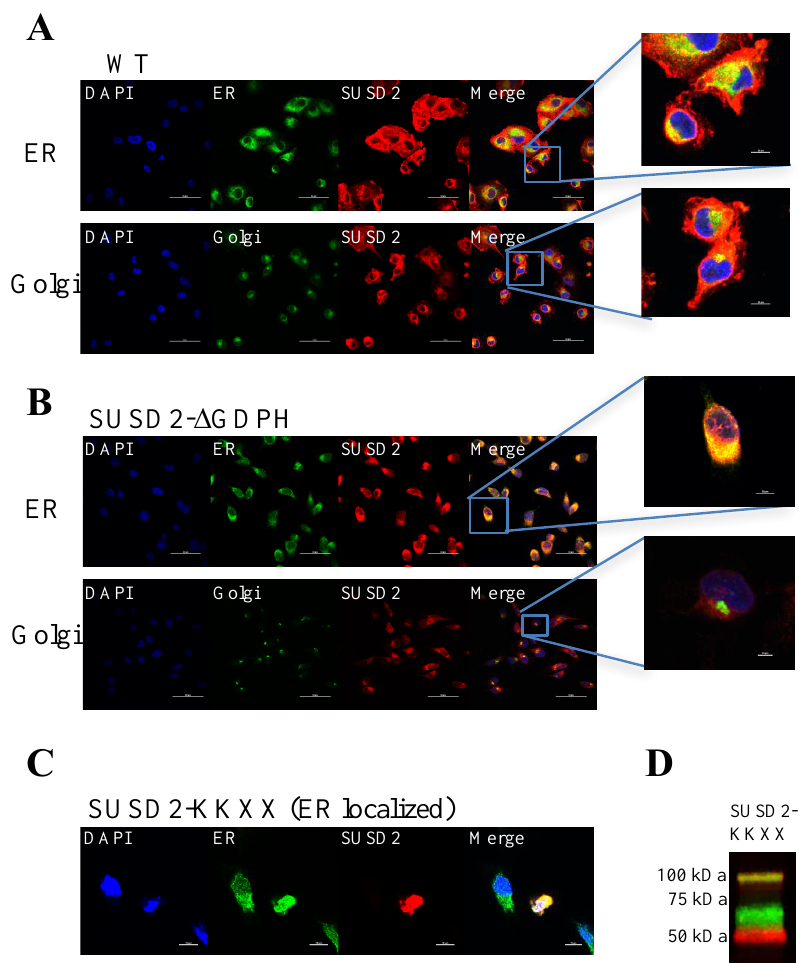
Figure 3. Immunofluorescence staining of stable MDA-MB-231-SUSD2 and stable MDA-MB-231- SUSD2- ∆ GDPH cells. Cells were grown on glass coverslips overnight. Prior to staining, cells were fixed with 2% paraformaldehyde and permeabilized with 0.2% Triton X-100. ( A ) MDA-MB-231-SUSD2 or ( B ) MDA-MB-231-SUSD2- ∆ GDPH cells were stained for SUSD2 (anti-SUSD2, red) and endoplasmic reticulum (ER) (anti-KDEL, green) (top panels), or for SUSD2 (anti-SUSD2, red) and Golgi (anti-58K Golgi, green) (bottom panels). Nuclei are stained blue using DAPI. ( C ) E ff ect of an ER retention signal on SUSD2 processing. MDA-MB-231 cells were transiently transfected with an expression construct encoding SUSD2 fused to an ER retention signal (SUSD2-KKXX). Cells were stained for both SUSD2 and ER using anti-SUSD2 (red) and anti-KDEL (green) antibodies to confirm ER localization of this mutant. ( D ) SUSD2-KKXX is cleaved in the ER. Western immunoblot analysis of 293T cells transiently transfected with pSUSD2-KKXX was performed. Cell lysates were separated by gel electrophoresis, transferred to a PVDF membrane, and probed with anti-N-terminal (red) and anti-C-terminal (green) SUSD2 antibodies. Yellow staining indicates the presence of the full-length polypeptide.